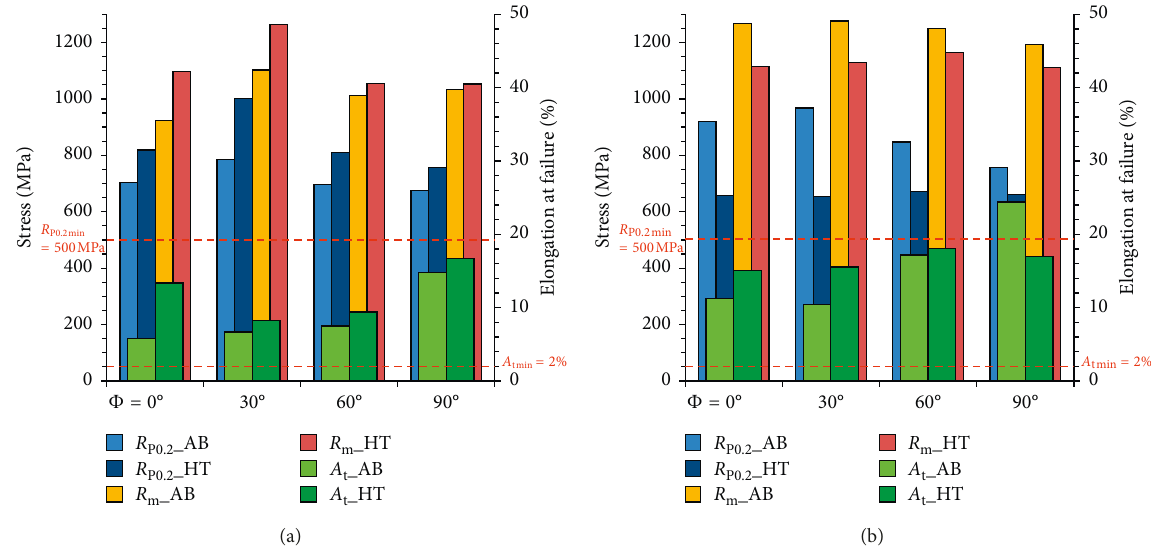
Figure 8: R P0.2 , R m , and A t values for Co-Cr-Mo (a) and Co-Cr-W (b)